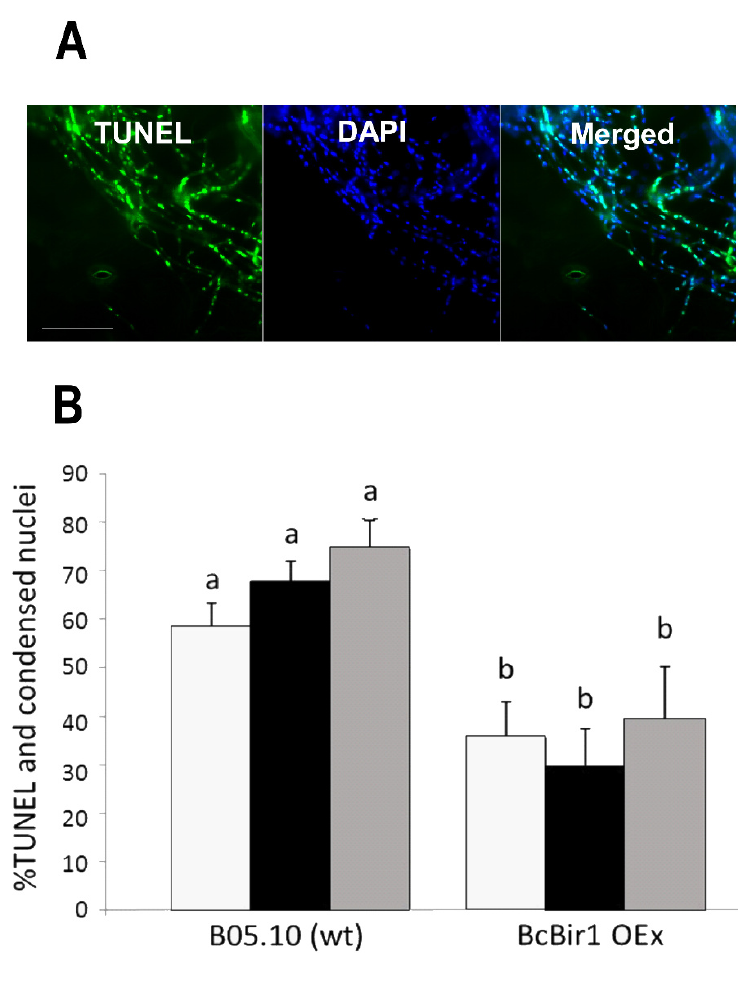
FIGURE 6: Quantification of TUNEL and compari- son with chromatin condensation. (A) Images of infected leaves stained with TUNEL and DAPI. Leaves of A. thaliana cv. Col-0 were inoculated with conidia of B. cinerea wild type strain. TUNEL